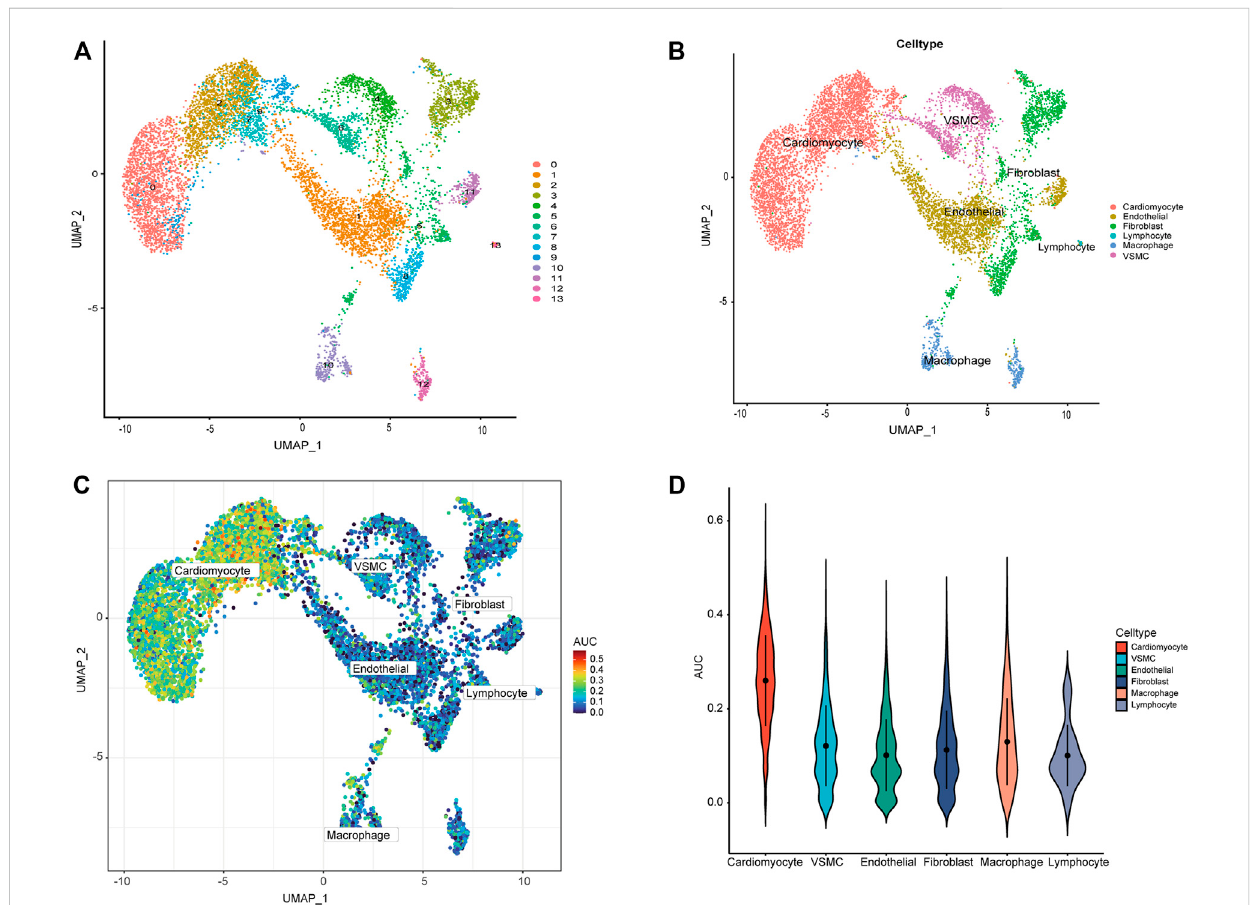
FIGURE 8 ScRNA-seq analysis reveals the expression of CRGs. (A) The tSNE plots of cardiac tissue cell populations. Each dot depicts a cell, depending on the cell population. (B) De fi ned cardiac tissue cells (cardiomyocytes, endothelial, fi broblasts, Lymphocyte, macrophages, and VSMC). (C) AUC of the CRG score visualized by T-SNE. (D) Visualization of CRG scores of different cells by violin plot.